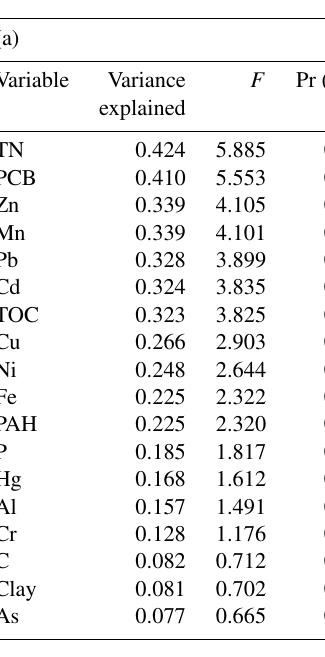
Table 1. Results of the forward model selection in the redundancy analysis. Proportion of variance explained in the community data ( R 2 ) , from permutation tests (10 000 permutations were used) are reported for (a) models with a single explanatory variable and (b) for the effects of a second variable added to the model already including total